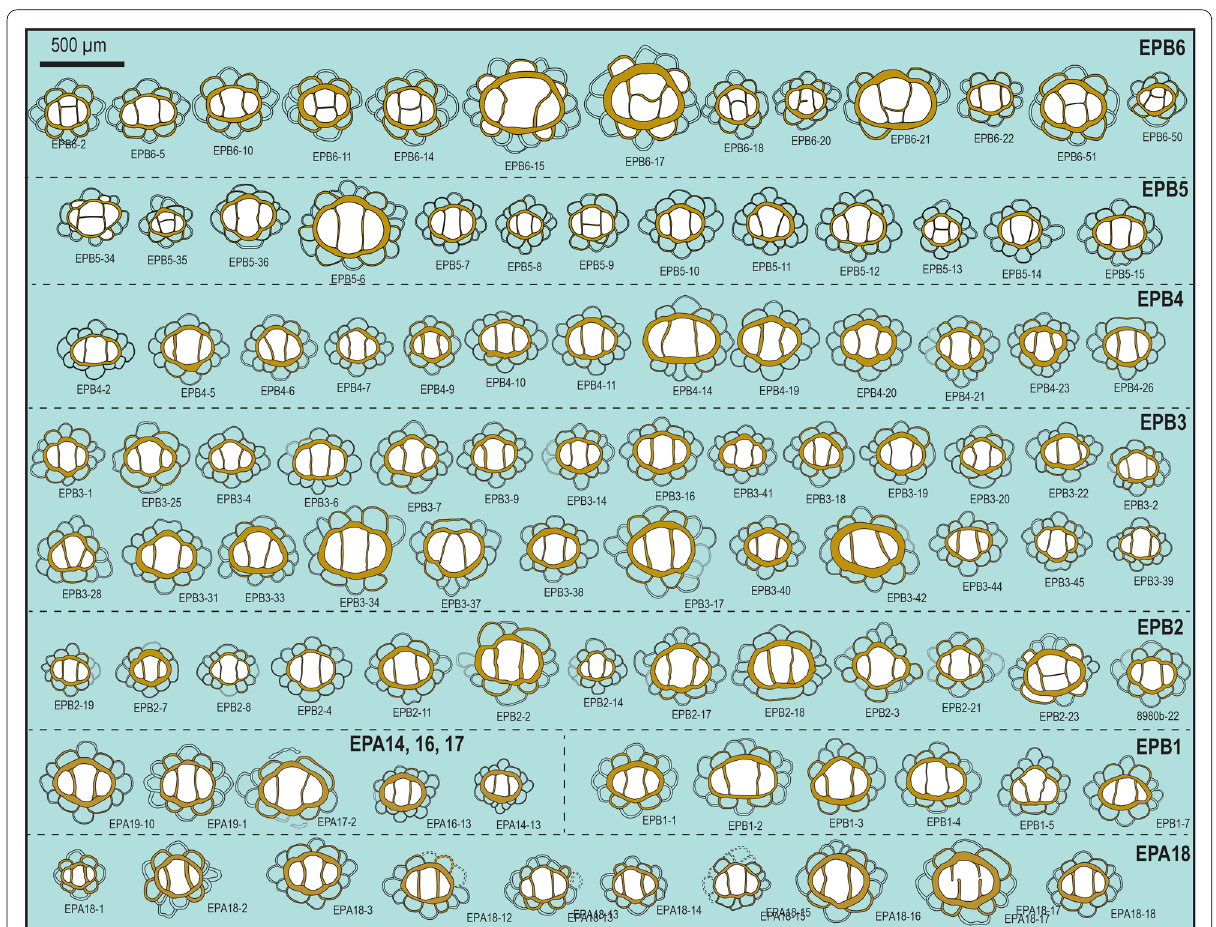
Fig. 18 Line drawings of the embryonic–nepionic stages of O. pamiri Meriç from the Taraklı Formation in Epçeler A, B and Dereköy